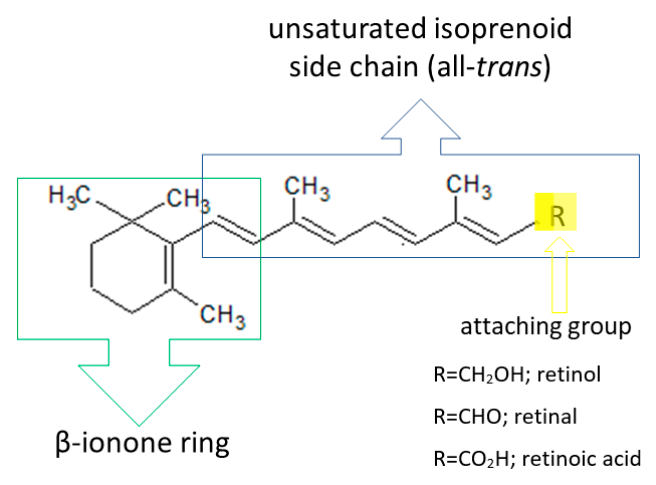
Figure 2. Basic structure of retinoids (own work based on [32]).